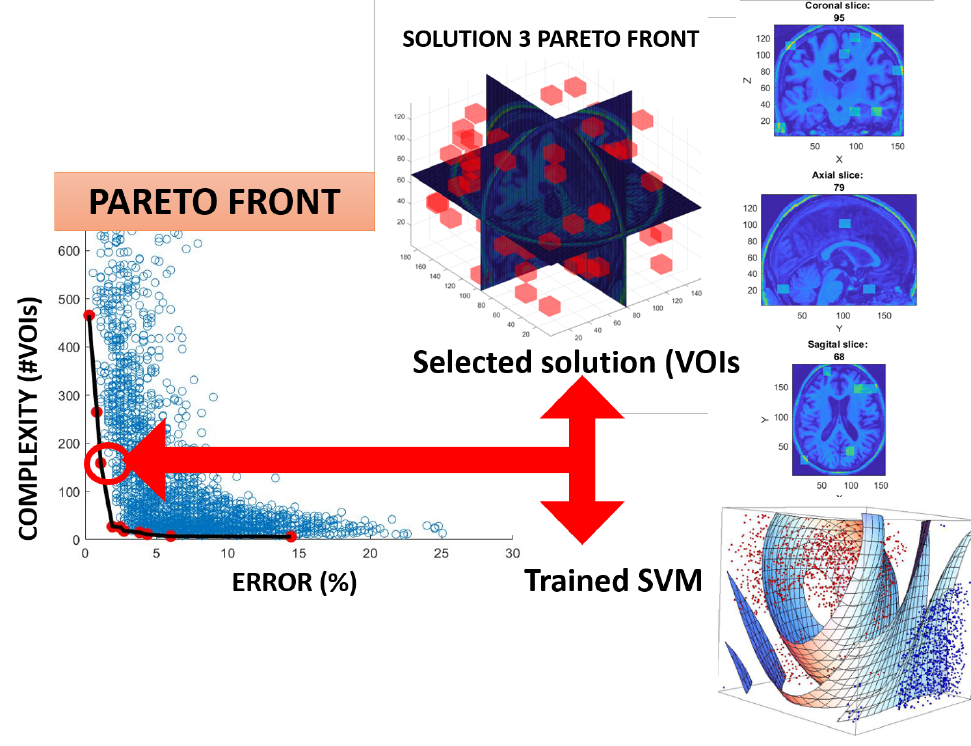
Figure 10. Non-dominated solutions from the Pareto Front, representing a sets of selected VOIs and its corresponding SVM